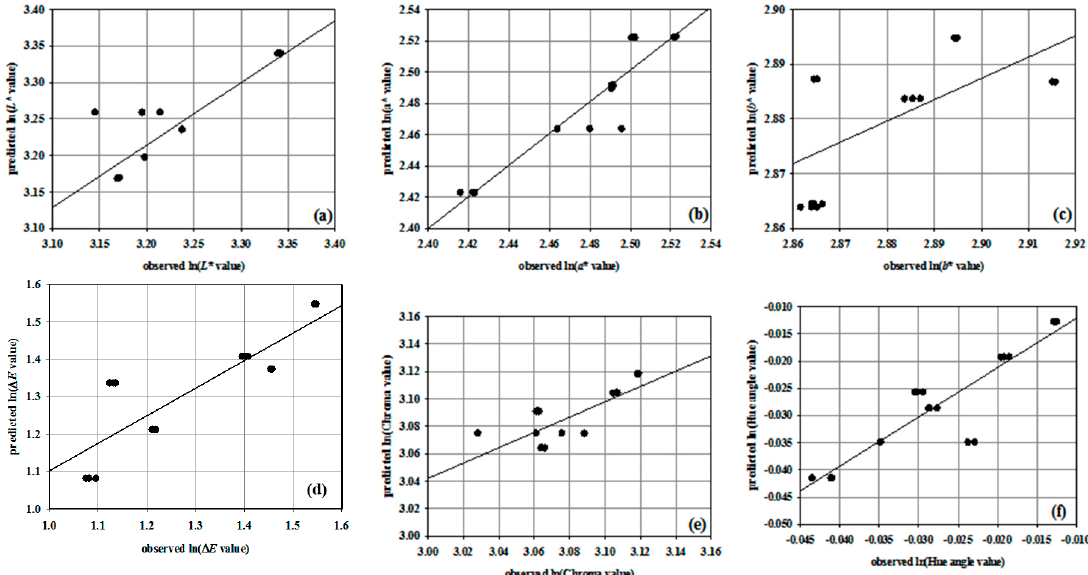
Figure 5. Linear regression models for description of colour component change during storage of L1KMK estimated using the Eureqa Formulize: ( a ) L *, ( b ) a *, ( c ) b *, ( d ) ∆ E , ( e ) Chroma, ( f ) Hue angle ( R 2 = 0.714, 0.856, 0.400, 0.724, 0.509, 0.561).